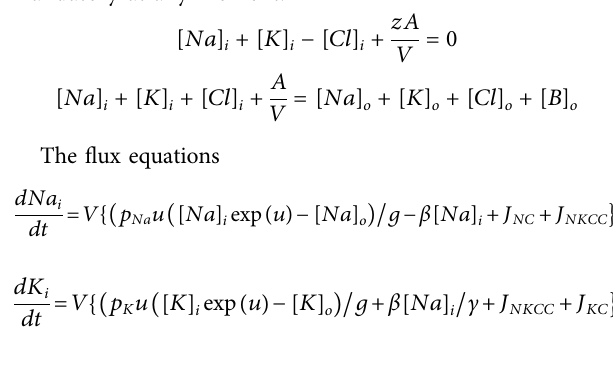
The left-hand sides of these three equations represent the rates of change of cell ion content. The right-hand sides express fl uxes, where u is the dimensionless membrane potential related to the absolute values of membrane potential U (mV), as U (cid:1) u RT/F (cid:1)